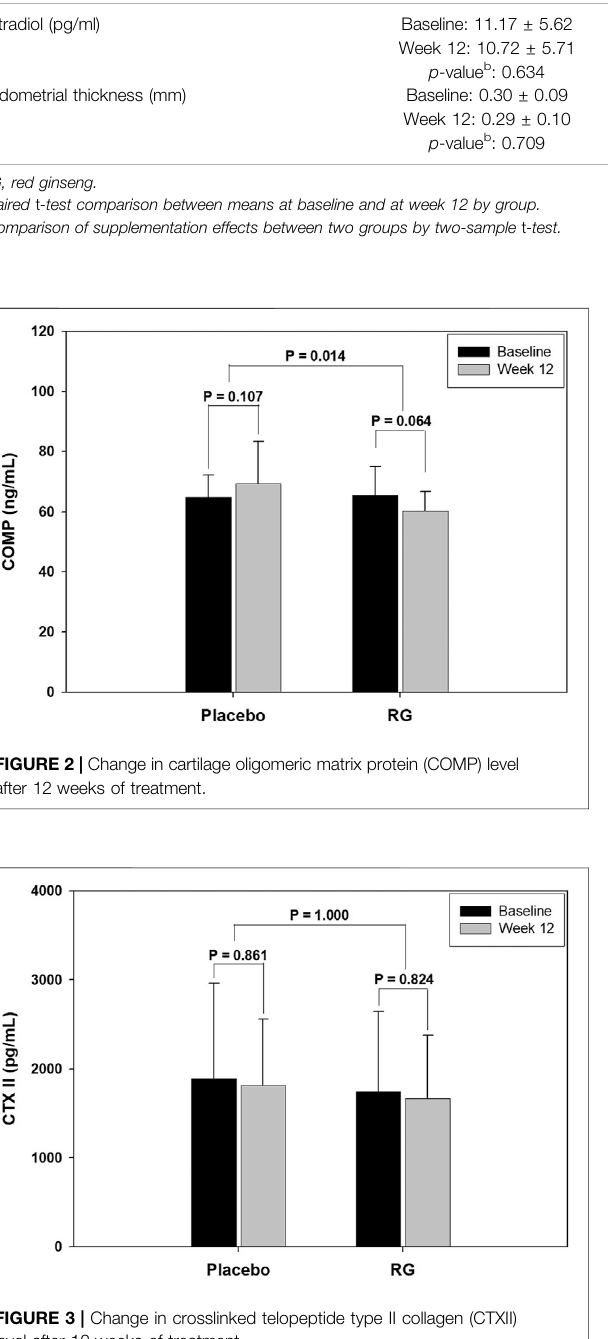
FIGURE 3 | Change in crosslinked telopeptide type II collagen (CTXII) level after 12 weeks of treatment.